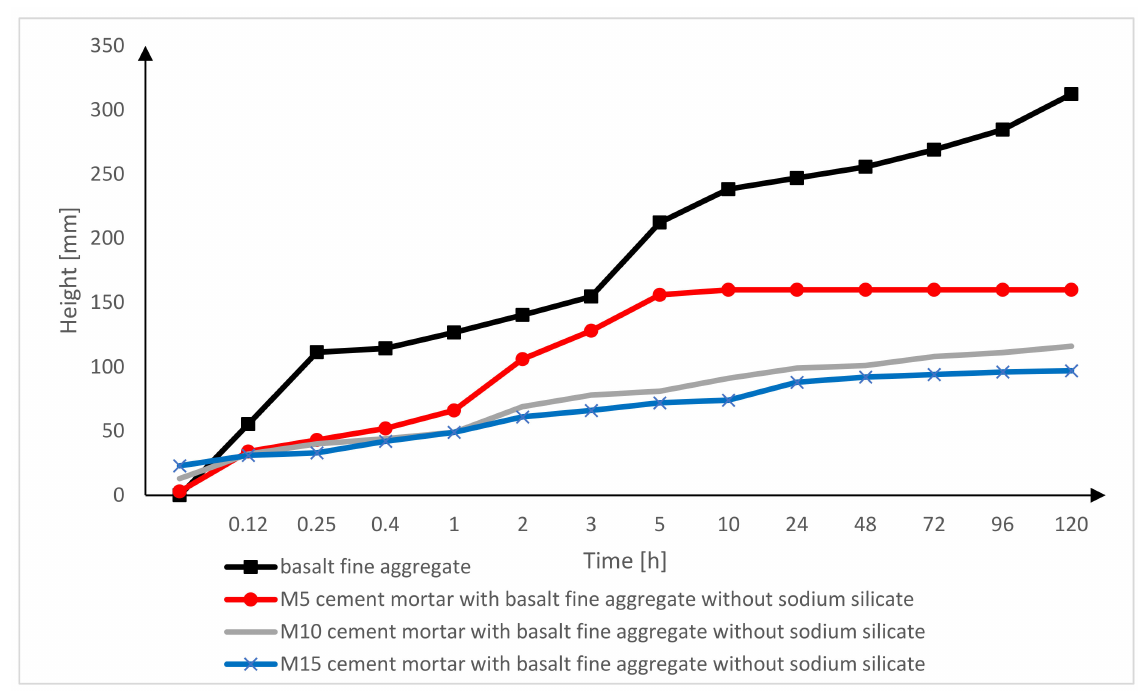
Figure 13. Comparison of the results of the capillary suction of the M5, M10, M15 cement mortar bars without sodium silicate with basalt fine aggregate.